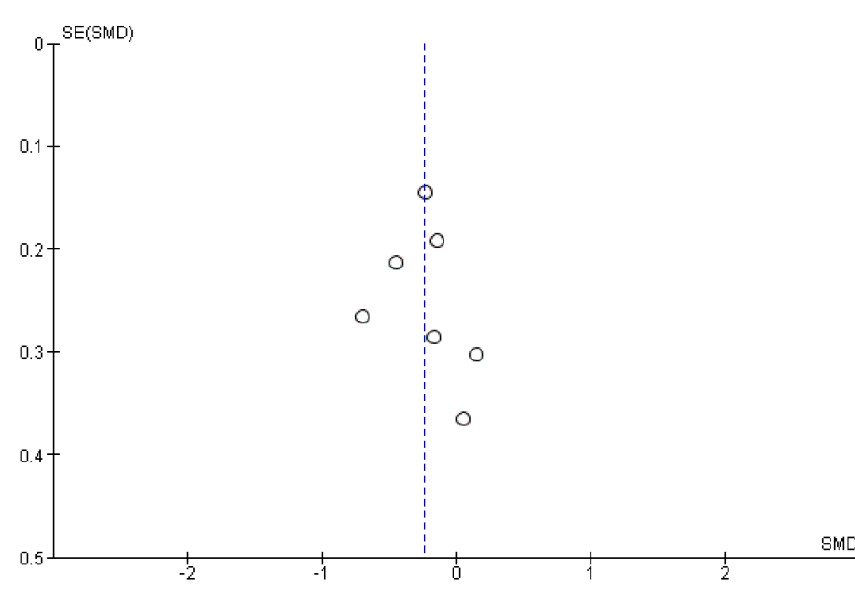
Figure 3. Funnel plot of the included RCTs for symptom score after treatment.